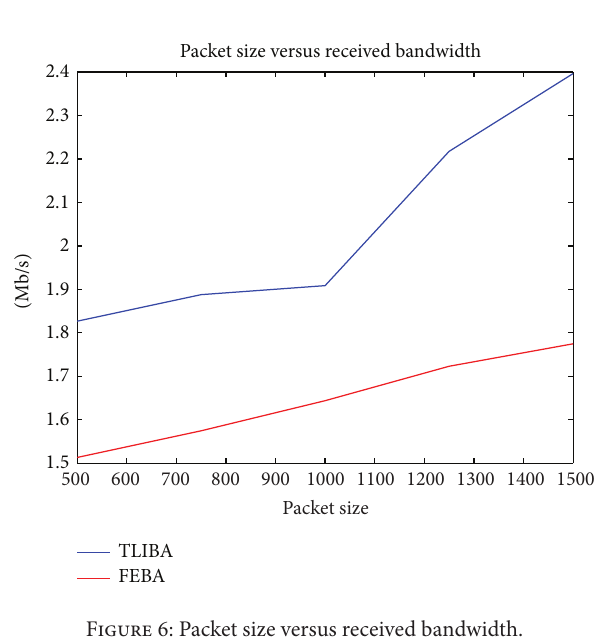
Figure 6: Packet size versus received bandwidth.